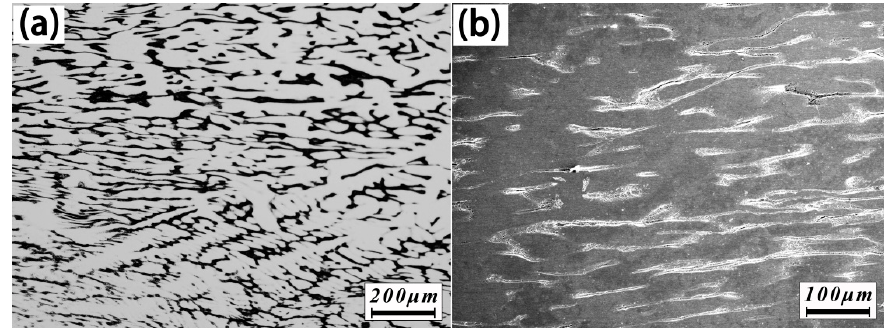
Figure 6. The metallographs of the ZrTiHfV 0.5 Nb 0.5 alloys after being compressed: ( a ) Optical microscope (OM); ( b ) Scanning electron microscope (SEM).